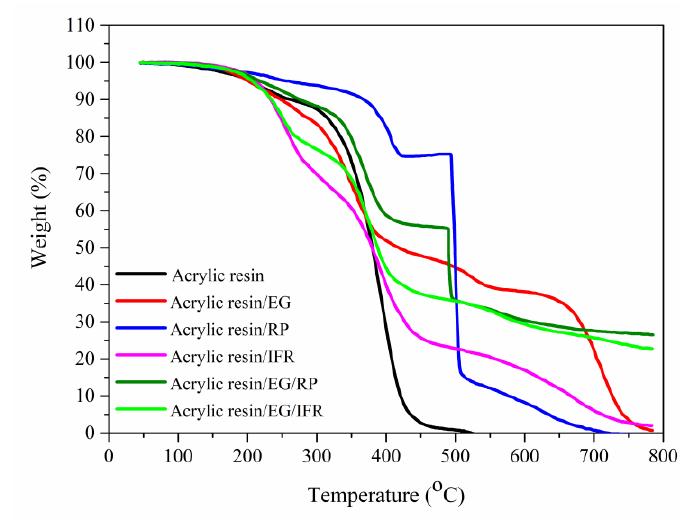
Figure 8. TGA curves of different flame-retardant coatings.